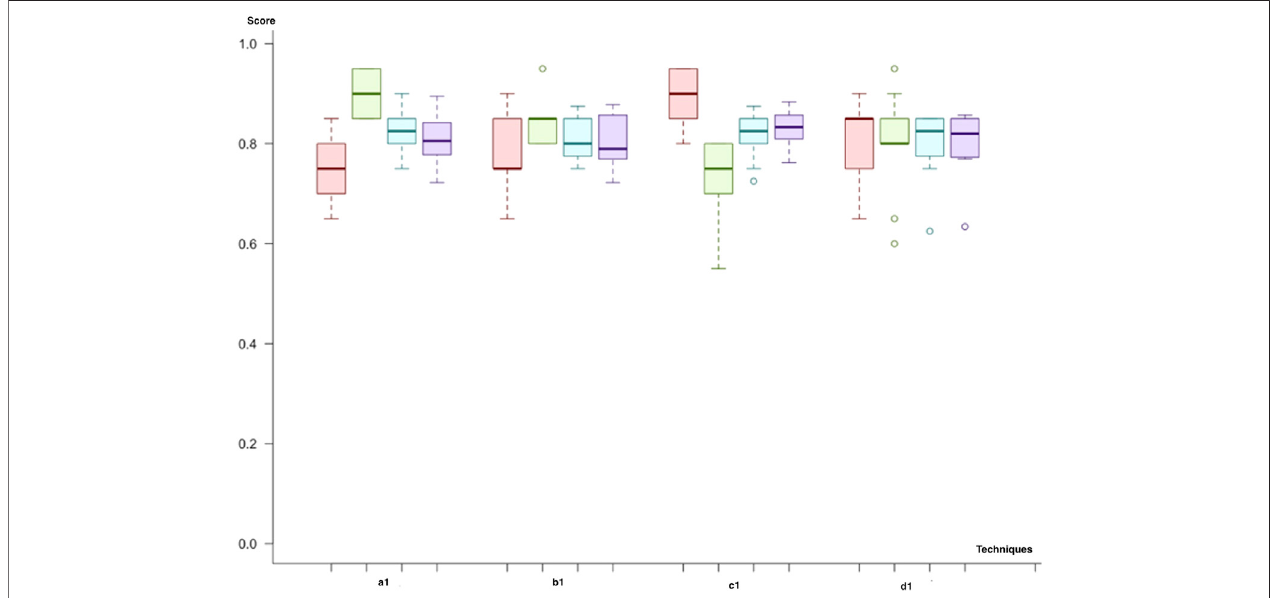
FIGURE 6 | Model comparison of techniques used for miRNA biomarkers (red, sensitivity; green, predictivity; blue, accuracy; purple, F-score): Category 1, which uses a hybrid model of feature selection and an AdaBoost classi fi er, has the best results among all scenarios.